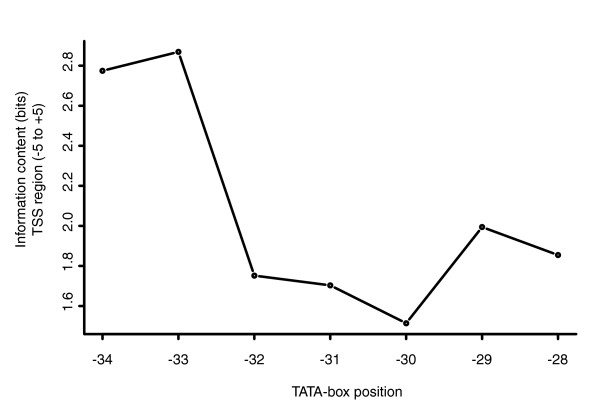
Non-optimal TATA-TSS spacing is compensated for by increased signal strength in the TSS region. The signal strength around the initiation site [-5,+5] (measured as information content in bits [45]) is lowest in promoters that have the most favored TATA-TSS spacings (30 and 31 bp). The signal strength is increased in promoters with a TATA-TSS spacing ranging from 32 to 34 bp. This increase is due to an extended initiation site motif, as shown in corresponding sequence logos in Figure 6. bp, base pairs; TSS, transcription start site. bp, base pairs; TSS, transcription start site.